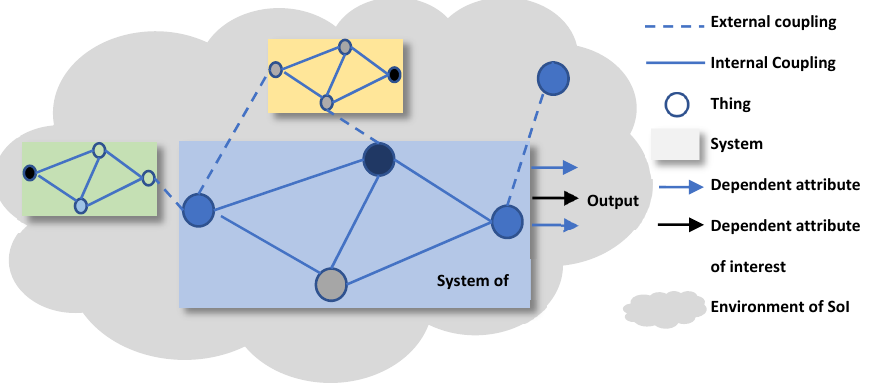
Figure 2. A General System Representation.